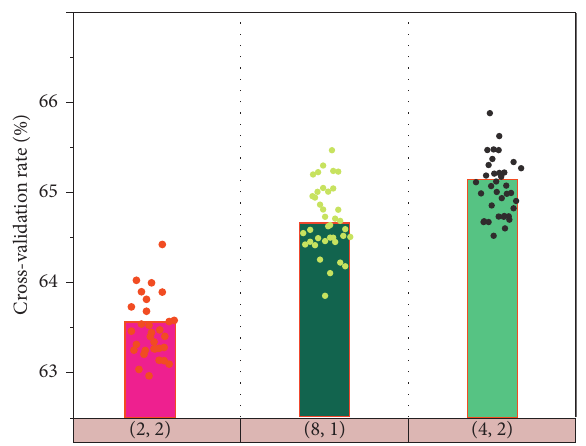
Figure 8: Parameter combination and cross-validation accuracy of postinvestigation.